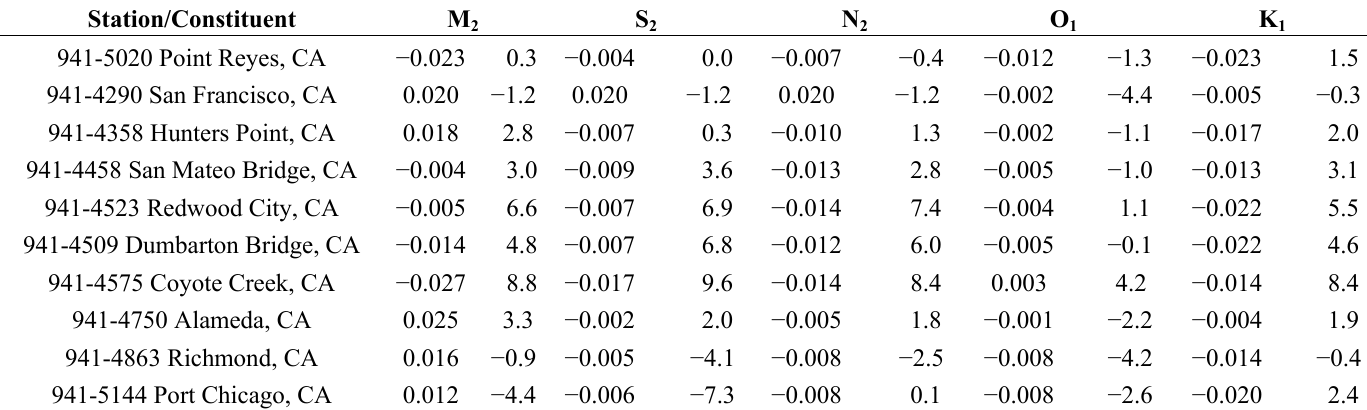
Table 5. Harmonic Analysis of 19-month tidal simulation water level comparison to NOS accepted tidal constituents. Accepted constituent values of amplitudes (m) and phase (degrees) minus model predictions. Note negative amplitude differences denote an under prediction of tidal water level constituent amplitudes, while positive phases denote a lag in tidal water level constituent propagation.